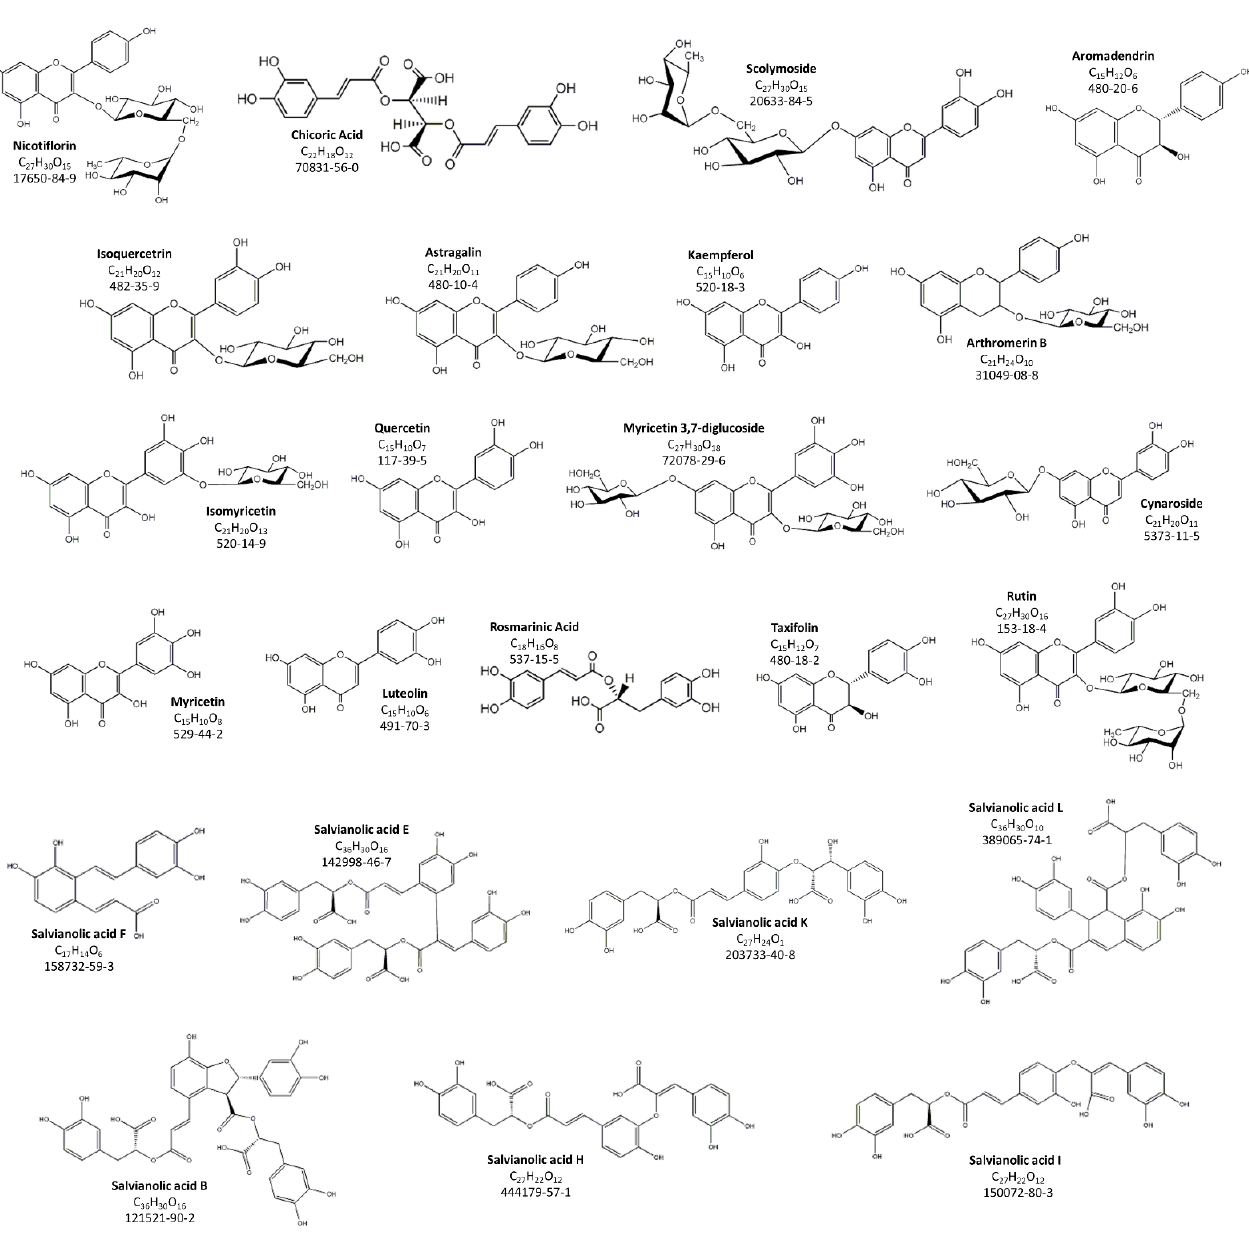
Figure 1. Polyphenolic compounds identified in F1-BEO via HPLC-ESI-MS/MS. Table 2. Identification and Quantification of Volatile Organic Compounds (VOCs) in F1-BEO. CAS ID: Chemical Abstracts Service Identification